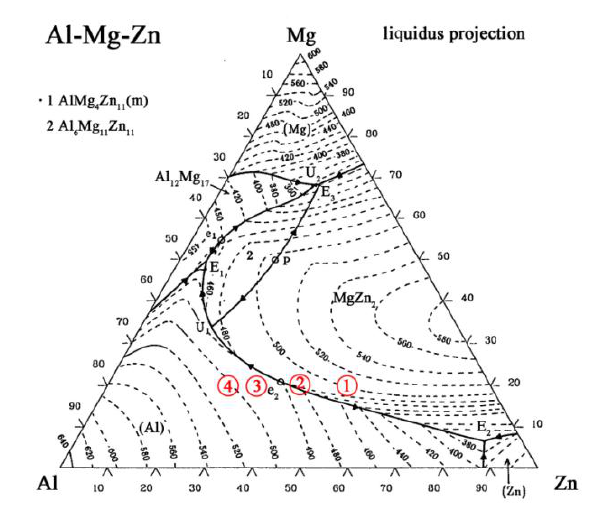
Figure 4. Mg–Al–Zn ternary phase